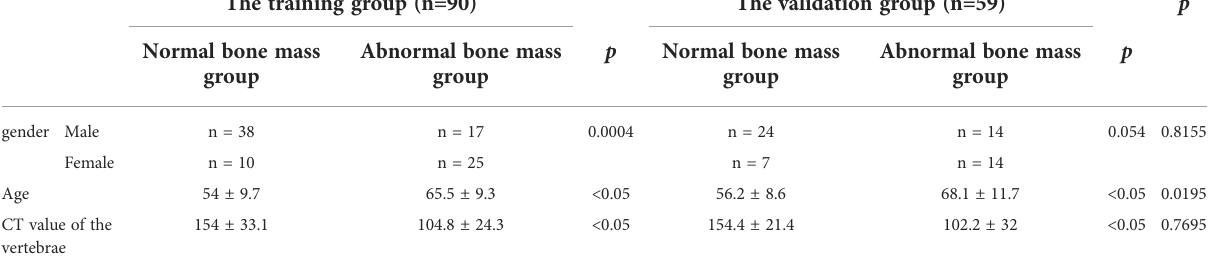
TABLE 1 Basic clinical information about the patients in this